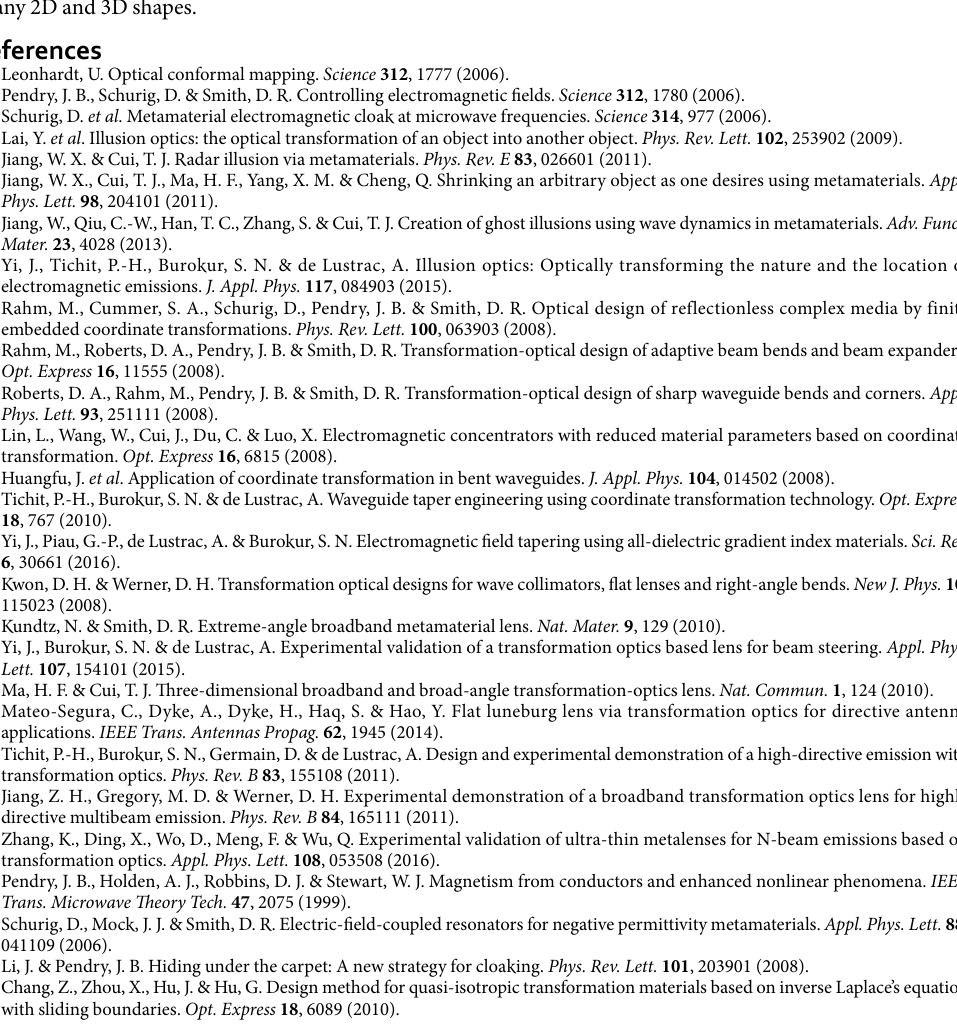
range. The lens has been numerically characterized in the microwave region from 7 GHz to 13 GHz. The near-field distributions have shown that such a lens is able to flatten the cylindrical wavefronts from a horn antenna into planar ones in order to produce a highly directive radiation pattern. Furthermore, far-field antenna patterns have shown directive emissions from the horn antenna over the tested frequency range. The method proposed in this paper is low-cost and can be easily implemented at microwave frequencies. Such all-dielectric devices present real potential applications in airborne and communication systems. The method is general and can be freely applied to any 2D and 3D shapes.